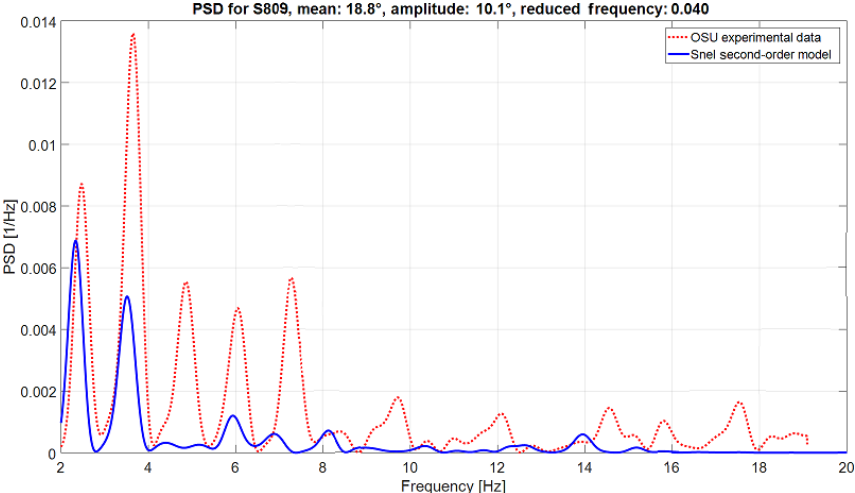
Figure 11. Power spectral density of experimental data and the improved Snel model (S809 aerofoil with mean angle of attack of 18.8 ◦ , amplitude of 10.1 ◦ , and reduced frequency of